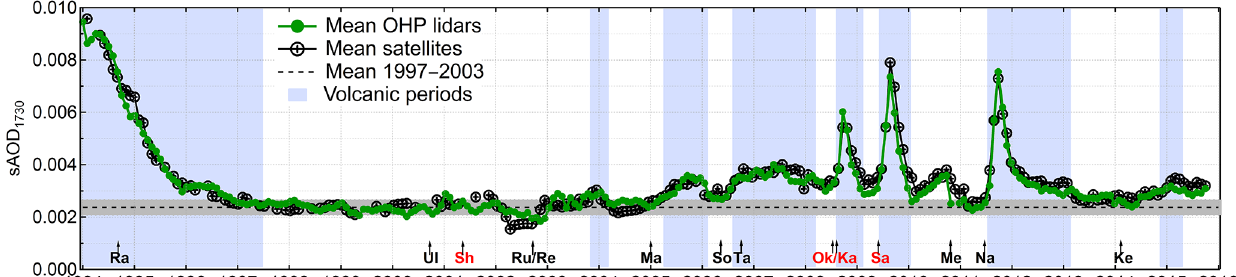
Figure 3. Time series of monthly mean sAOD 1730 computed by averaging both OHP lidars and all satellites. VEI 4 eruptions>20 ◦ S (Table 3) are indicated along the x axis, NH midlatitude eruptions are marked red. The horizontal dashed line and grey shading indicate the average value of sAOD 1730 over the reference quiescent period and its ± 1– σ range of values, respectively (2.37 × 10 − 3 ± 12.6%). Time periods considered as perturbed by volcanism are shaded light blue. See text for details. Table 3. List of volcanic eruptions of VEI 4 occurring in the tropics and Northern Hemisphere (>20 ◦ S) between 1994 and 2016 as reported by the Smithsonian Institution Global Volcanism Program (http://volcano.si.edu). The temporal extent of the volcanically perturbed period at OHP from the corresponding eruption is provided in the rightmost two columns. Volcano (VEI 4) Eruption date Latitude Start of period End of period Rabaul